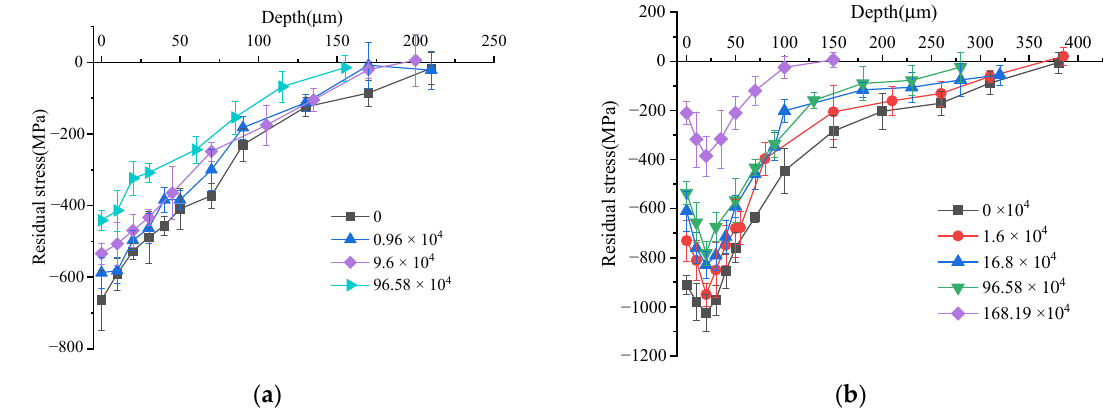
Figure 8. Residual stress distribution evolution during fatigue process. ( a ) Turning residual stress; ( b ) Ultrasonic impact residual stress.